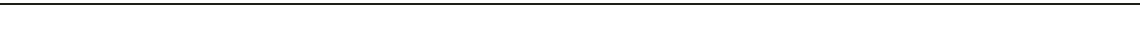
Fig. 3 RamDA-seq analyses of cell differentiation. a A diffusion map of the cells collected over time and colored by the sampling time points. DC, diffusion component. The numbers in parentheses represent the number of cells. b Heat maps of the expression levels of non-poly(A) (left) and the other (right) transcripts. Rows are ordered and colored by clusters. Columns are ordered by pseudotime and colored by sampling time points. Smoothed values are transformed to Z -scores for each row. Raw values are scaled from 0 to 1 for each row. c (Left) Averaged expression pro fi le for each cluster. The x -axis represents pseudotime. Thin, colored areas represent SDs. The numbers before and after the slash in the parenthesis represent the numbers of non-poly (A) transcripts and all transcripts included in each cluster, respectively. (Right) Expression pro fi le of the representative transcript for each cluster. Each black curve represents a fi tted generalized additive model. d Expression pro fi les of two unannotated intergenic non-poly(A) transcripts measured by RamDA-seq (left) and single-cell preampli fi cation RT-qPCR (scRT-qPCR) (right). e (Top) Expression pro fi les of Neat1-001 measured by RamDA-seq (left) and scRT-qPCR (right). The x -axes represent pseudotime. (Bottom) Coverage plot of RamDA-seq at the Neat1 locus. The upper heat map represents the read coverage at the single-cell level. The middle plots represent the coverage averaged for cells at each time point as well as those of rdRNA-seq and paRNA-seq. Gene models are shown at the bottom. The arrowhead indicates the position of the qPCR primer. f The read coverage of the region common to both Neat1-001 and Neat1-002 (common) and the region speci fi c to Neat1-001 . The read coverage was normalized to the average of all cells. The asterisk indicates signi fi cant difference between two regions (Wilcoxon signed-rank test, p -value < 0.001 after Bonferroni correction). The center line, and lower and upper bounds of each box represent the median, and fi rst and third quartiles, respectively. The lower (upper) whisker extends to smallest (largest) values no further than 1.5 × IQR from the fi rst (third)